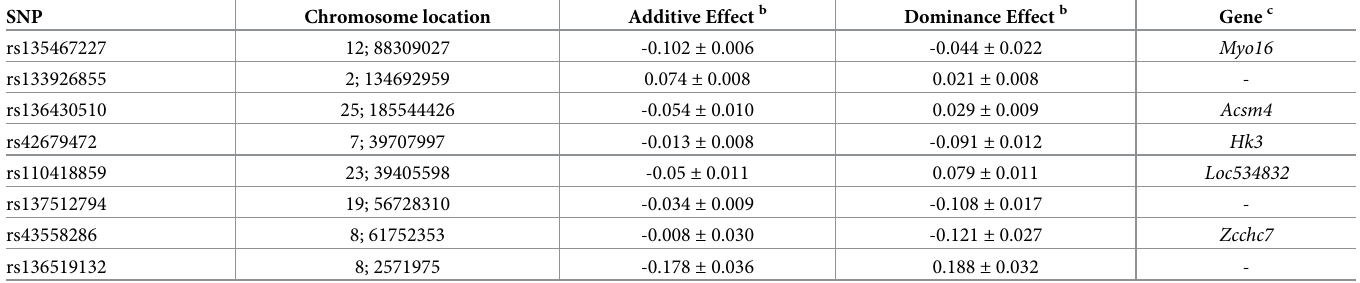
a Overall Response = E . coli O157:H7 SRP antibodies present at d 56 minus d 0 (time of initial vaccination). b Reported in Sample-to-Positive (S/P) ratio units. c If SNP is located within a known or predicted gene, the gene is reported.